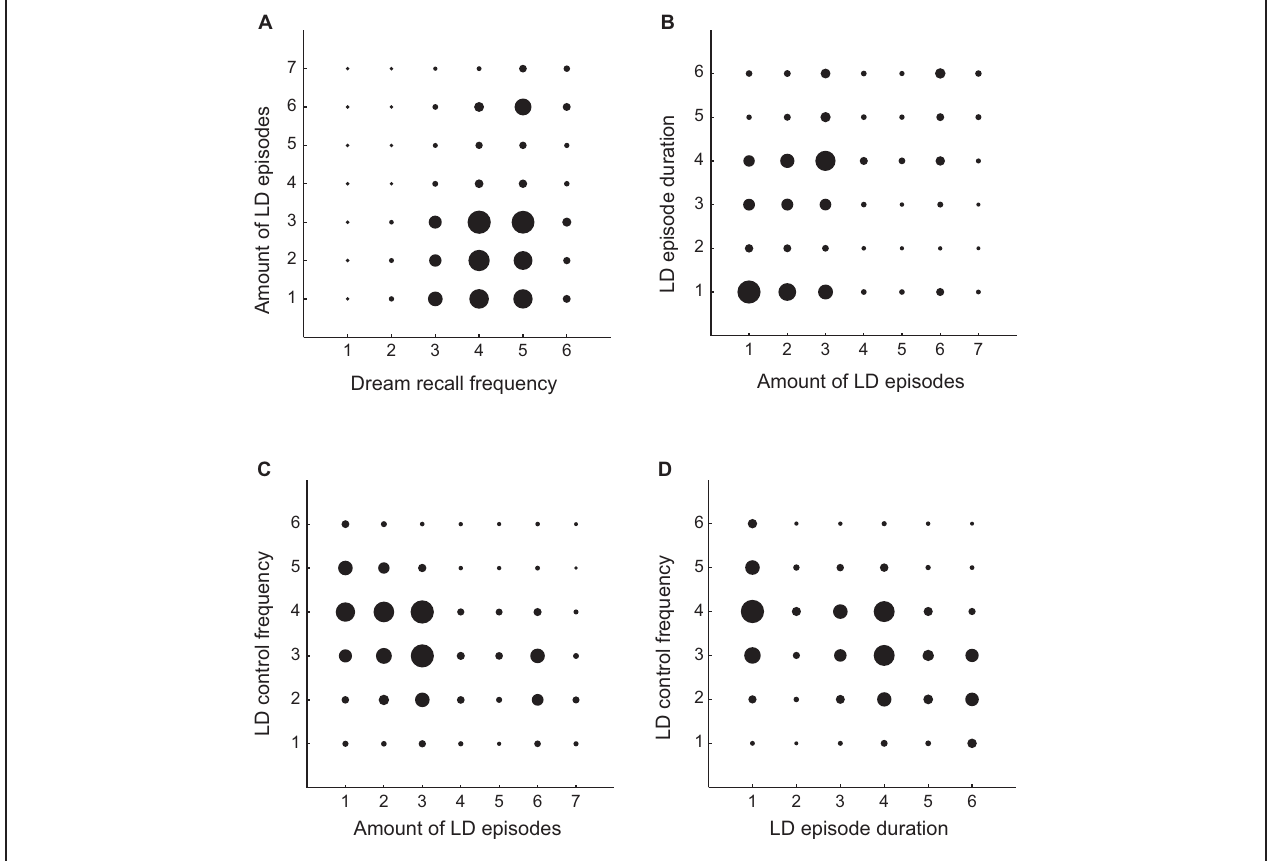
FIGURE 4 | Correlations between dreaming and LD features. ( A ) Amount of LD episodes and dream recall frequency ( r = 0.20, p < 0.01). ( B ) Amount of LD episodes and LD episode duration ( r = 0.34, p < 0.01). ( C ) Amount of LD episodes and LD control frequency ( r = − 0.33, p < 0.01). ( D ) LD control frequency and LD episode duration ( r = − 0.38, p < 0.01). The size of the black circles is associated with the number